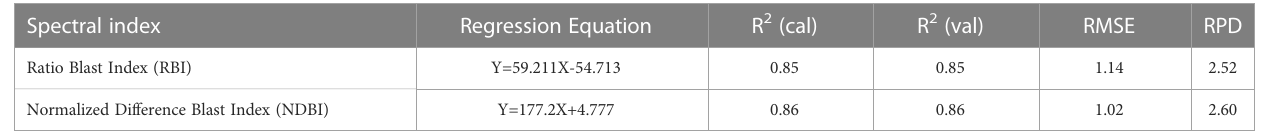
TABLE 8 Relationships of disease severity levels to RBI and